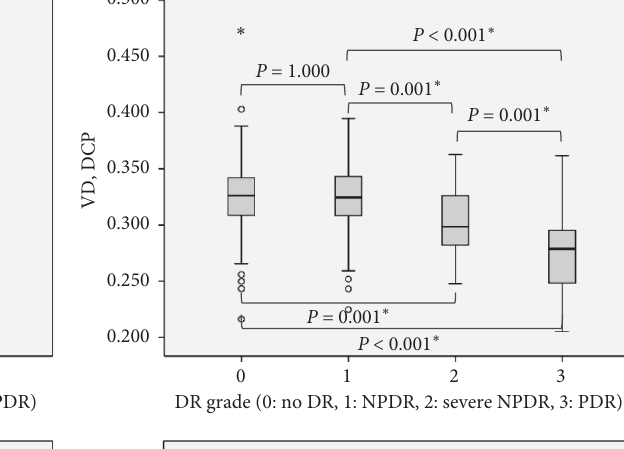
Table 2. Multivariate regression analysis including DR grade,